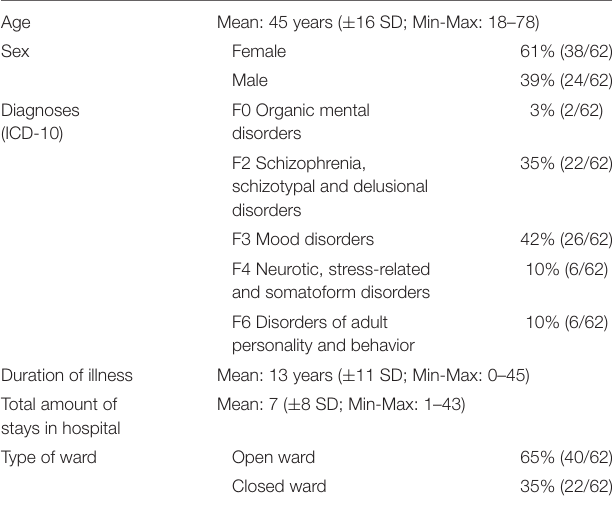
TABLE 1 | Patient